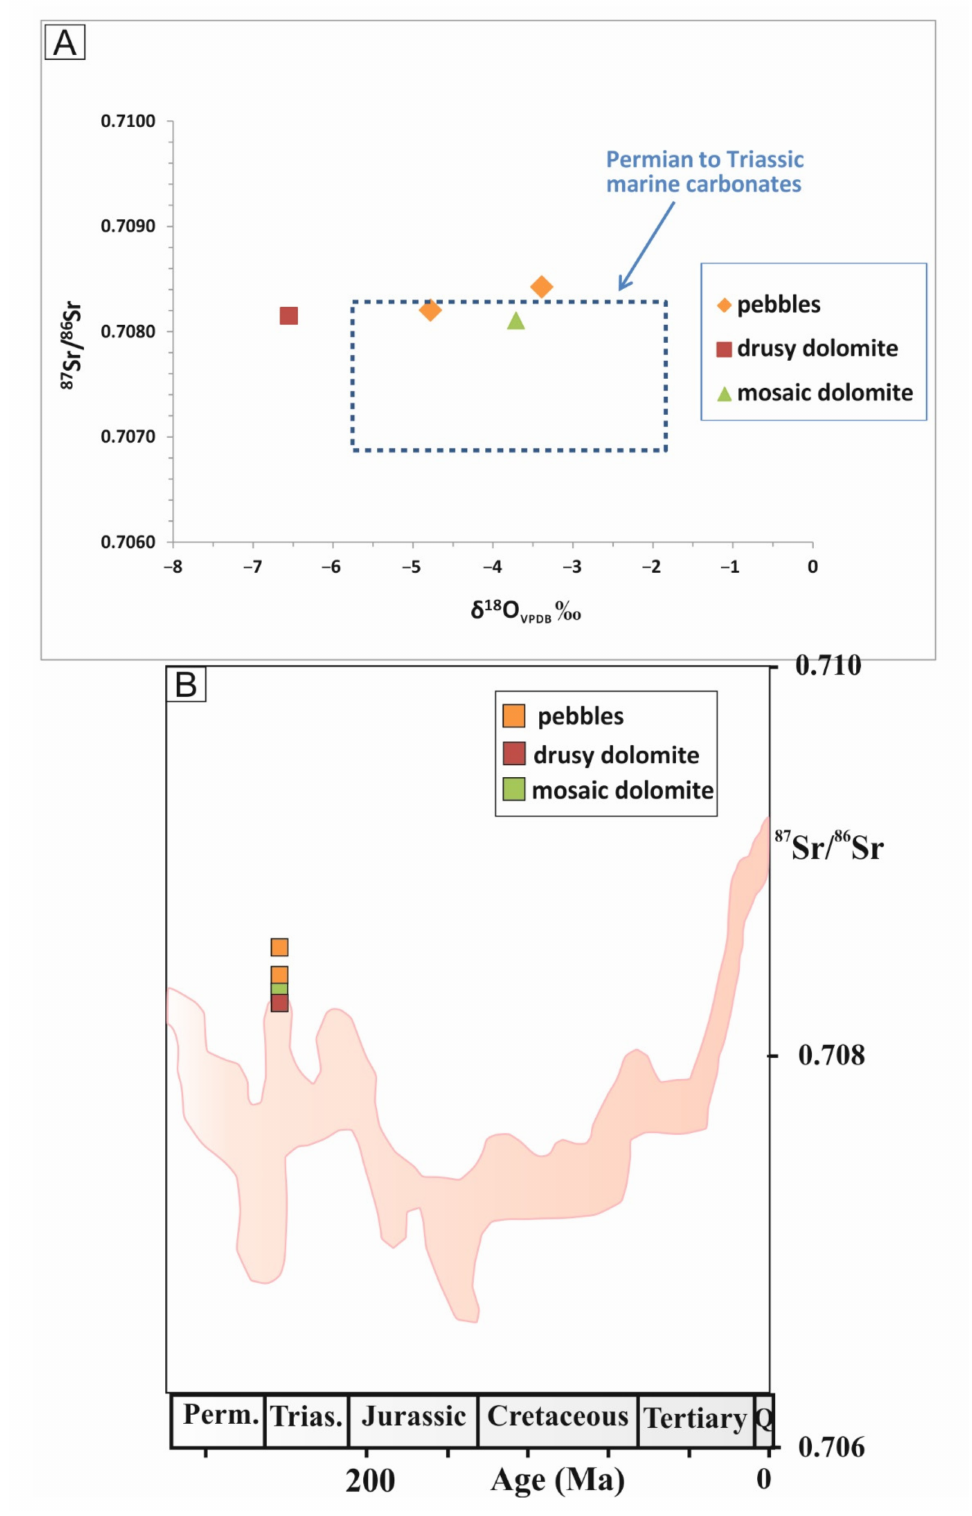
Figure 8. ( A ) Cross-plot of 87 Sr/ 86 Sr against δ 18 O VPDB showing two samples from the pebble have a slightly higher Sr isotope value than coeval marine carbonates. Two samples from drusy and mosaic dolomites are within the isotopic range of Permian to Triassic marine carbonates. The sample from drusy dolomite showing a lower δ 18 O VPDB value than coeval marine carbonates. ( B ) Measured 87 Sr/ 86 Sr ratios of different types of dolomite cements in the Bih Formation (Permo-Triassic) plotted on the sea water 87 Sr/ 86 Sr curve